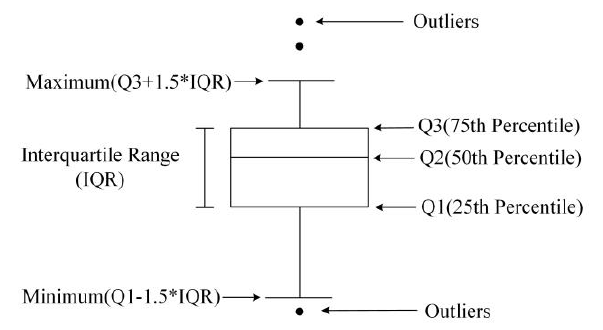
Figure 4. Illustration of Box line diagram